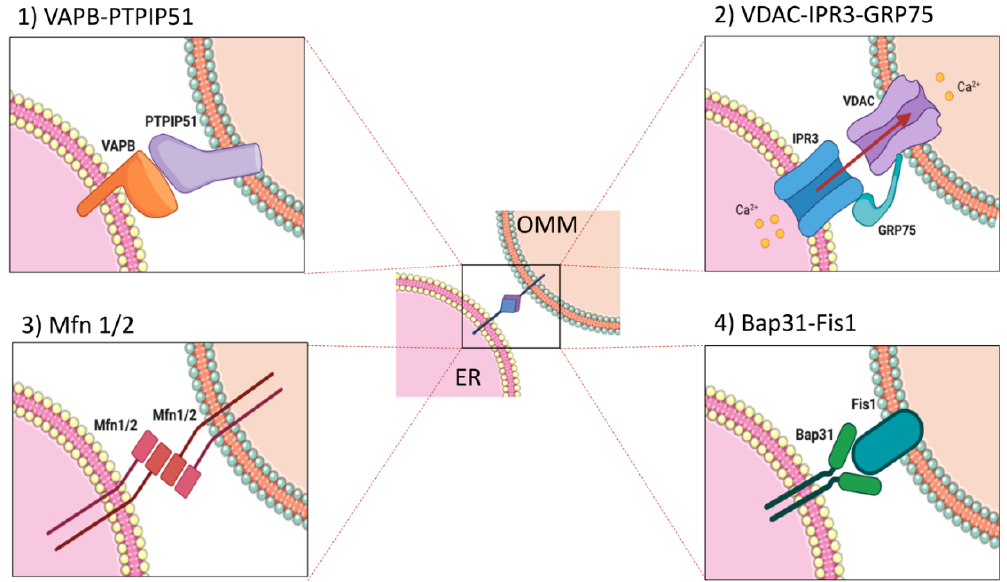
Figure 1. Schematic representation of the tethering complexes at the endoplasmic reticulum (ER)– mitochondria